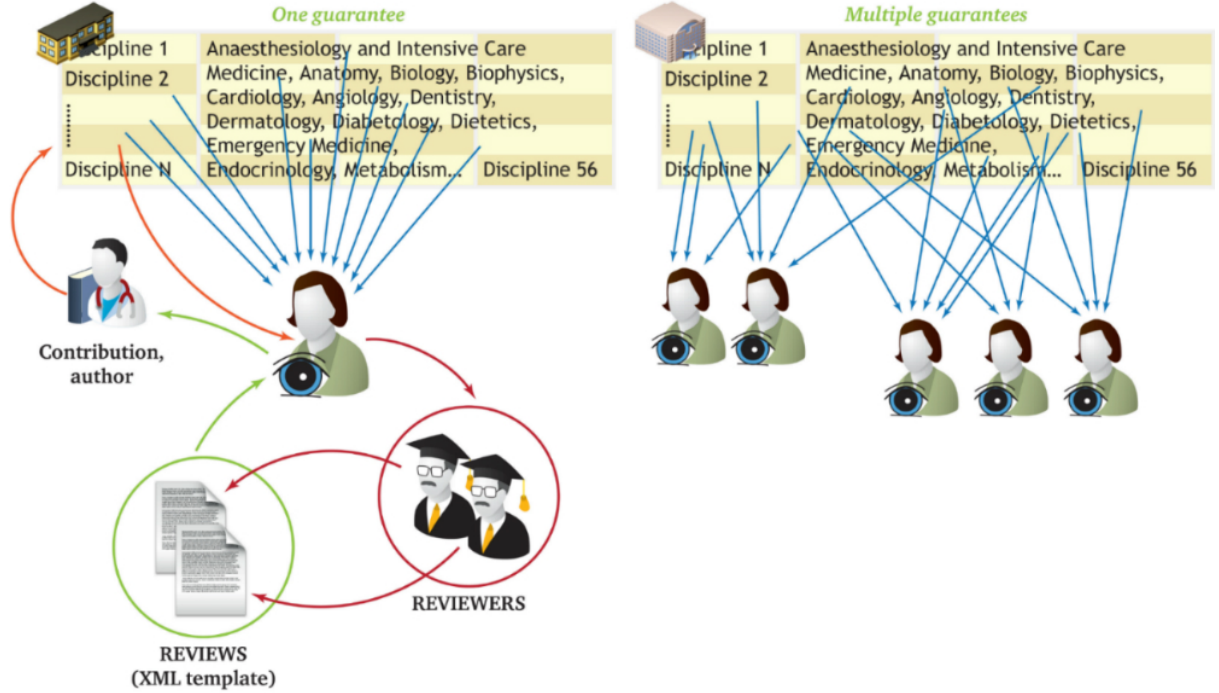
Figure 2. The contribution workflow scheme: (1) the author and technical editor finishes the contribution, (2) the guarantor, who is associated with a particular medical discipline, is notified about a new contribution to his/her field of interest, (3) the guarantor, either alone or with the help of the faculty’s editorial committee, invites 2 reviewers to present their reviews online with the use of template-generated